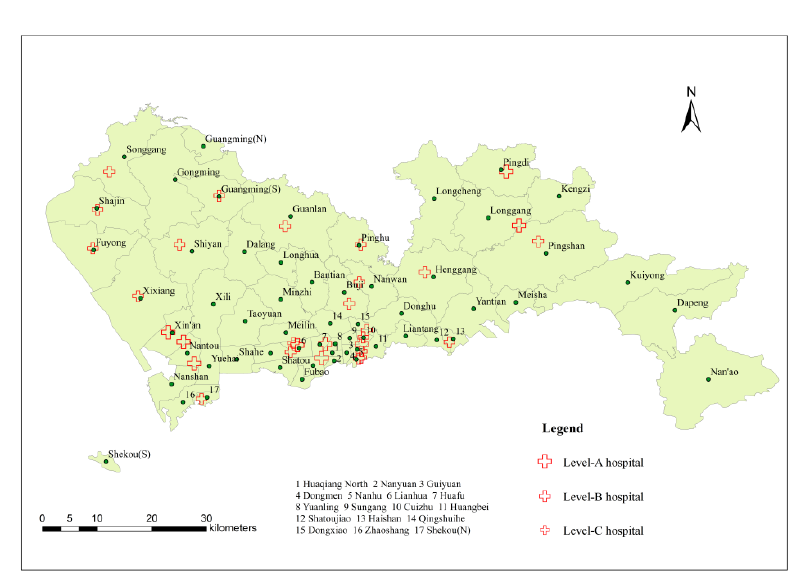
Figure 7. Distribution of liver disease